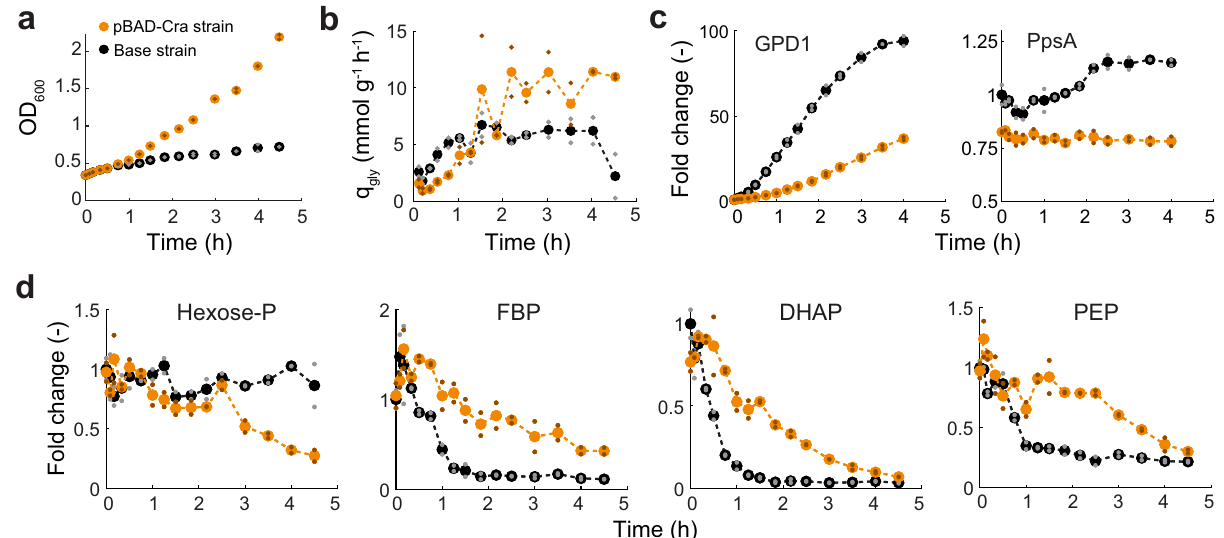
Fig. 5 Dynamic metabolite and protein responses to induction of the glycerol pathway. a Growth of the base strain (black) and the pBAD-Cra strain (orange). Glycerol production was induced by supplementing 0.5% ara to the medium at t = 0 h. Small dots show n = 2 independent shake fl asks, and large dots are the mean. b Speci fi c glycerol production rates (mmol g − 1 h − 1 ) were calculated for two adjacent time points as Δ c gly / c x / Δ t , where Δ t is the time interval between the two time points; Δ c gly is the difference of glycerol in the medium; c x is the biomass concentration. c Time-course of GPD1 levels and phosphoenolpyruvate synthetase (PpsA) levels. Proteomics samples were collected from the base strain (black) and the pBAD-Cra strain (orange) ( a ). Data are normalized to the 0 h time point of the base strain. d Time-course of the concentration of intracellular metabolites (Hexose-P hexose-phosphates, FBP fructose-1,6-bisphosphate, DHAP dihydroxyacetone phosphate, PEP phosphoenolpyruvic acid). Metabolomics samples were collected from the base strain (black) and the pBAD-Cra strain (orange) ( a ). Data are normalized to the 0 h time point of the base strain. Note that in b – d , the small dots show samples from n = 2 independent shake fl asks and big dots are the mean. Source data are provided in the Source Data fi